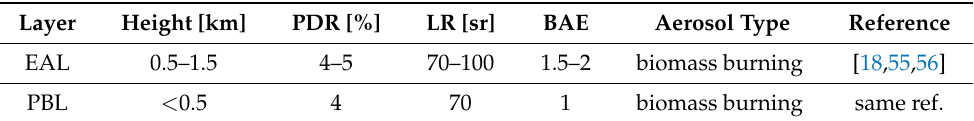
Figure 12. Results of simultaneous measurements in the IR Mie-Rayleigh, UV Mie-Rayleigh and UV Raman channels on 22 December 2017, 01:10–01:40 CET. ( a ) Backscatter coefficients at 1064nm (red) and at 355nm (blue); ( b ) extinction coefficient at 355nm; ( c ) the VDR and PDR at 355nm; ( d ) LR at 355nm and ( e ) the BAE between 355 and 1064nm. Range resolution of the backscatter coefficients retrieved using Klett method, VDR, PDR and BAE is 37.5m, while the backscatter and extinction coefficients retrieved using Raman method and LR were calculated with a 150m height smoothed window. Error bars stand for the uncertainties of the measured quantities and the two horizontal lines (black and green) denote stratified aerosol layers. Table 1. Aerosols in the observed aerosol layers (EAL and PBL) were characterized using observables sensitive to intrinsic aerosol properties. PDR and LR were obtained at 355nm, while the BAE was retrieved using both 355nm and 1064nm backscatter coefficients. Predominant aerosol type was chosen based on the values of aerosol optical properties of particular aerosol types, investigated in reference papers, and listed in the last